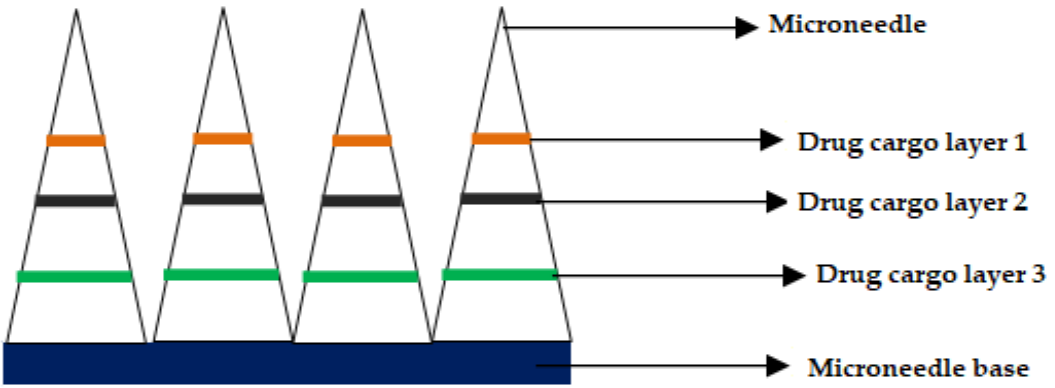
Figure 8. Cross-section of the microneedle after drug cargo loading by micro-milling.